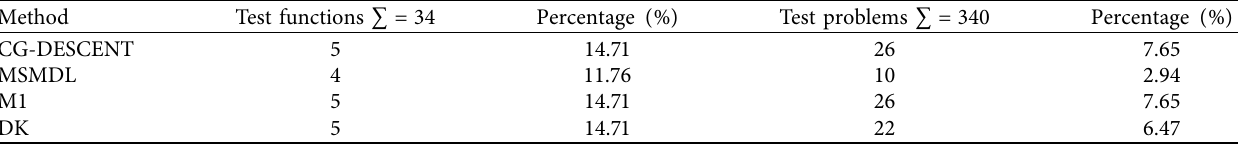
Table 3: Statistics of not successfully solved test functions by each